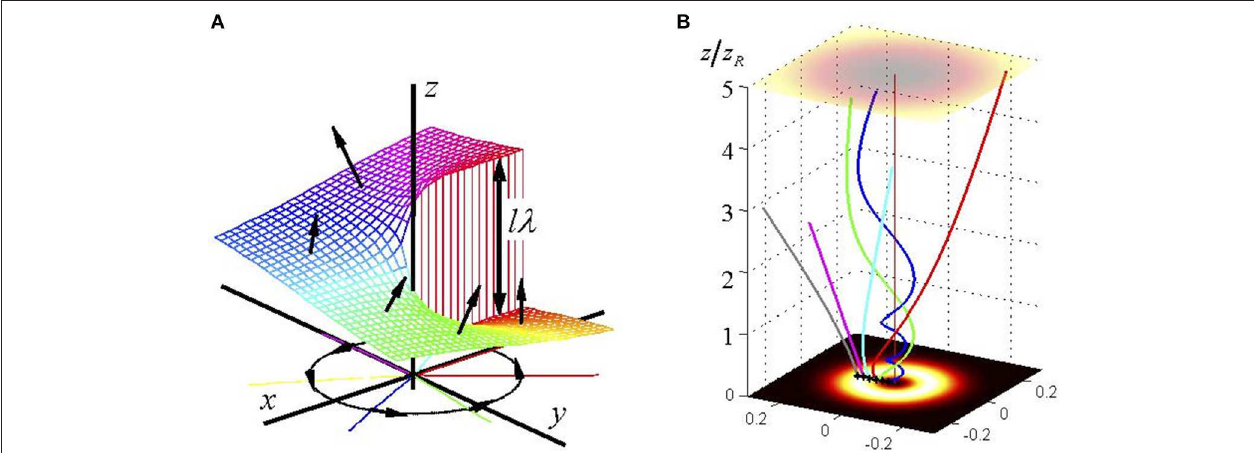
FIGURE 1 | (A) Wavefront of an optical vortex (OV) beam near the OV core. Normals to the screw-like surface are inclined with respect to the longitudinal direction; their azimuthal components form a close-loop circulation in the beam cross section. (B) 3D lines of the energy propagation in a circular OV beam for different distances from the beam axis in the waist plane z =